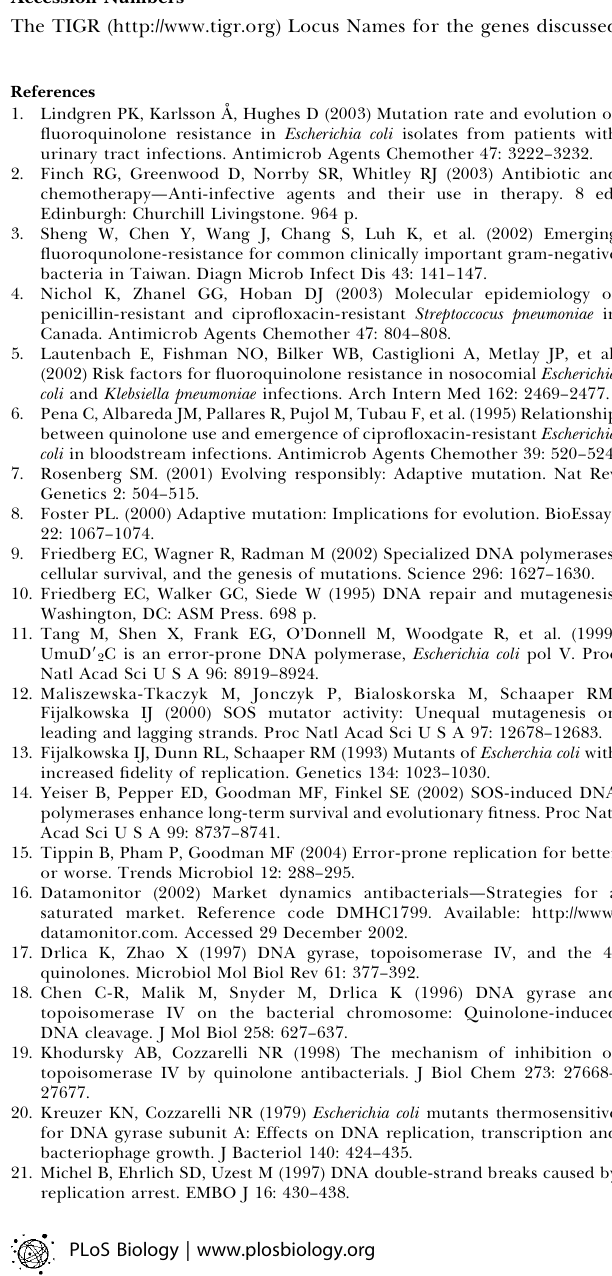
Table S1. Effect of Different Ciprofloxacin-Resistance Mutations Table S2. Primers Used in This